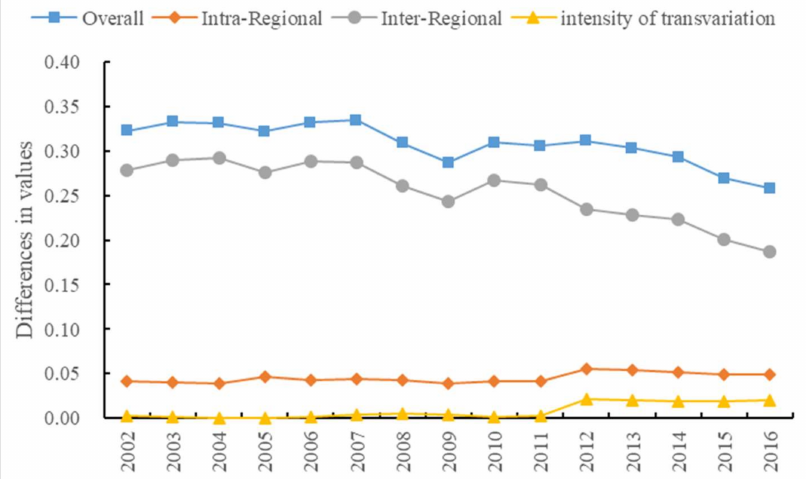
Figure 4. Regional differences in green development performance of the chemical industry in the Yangtze River Economic